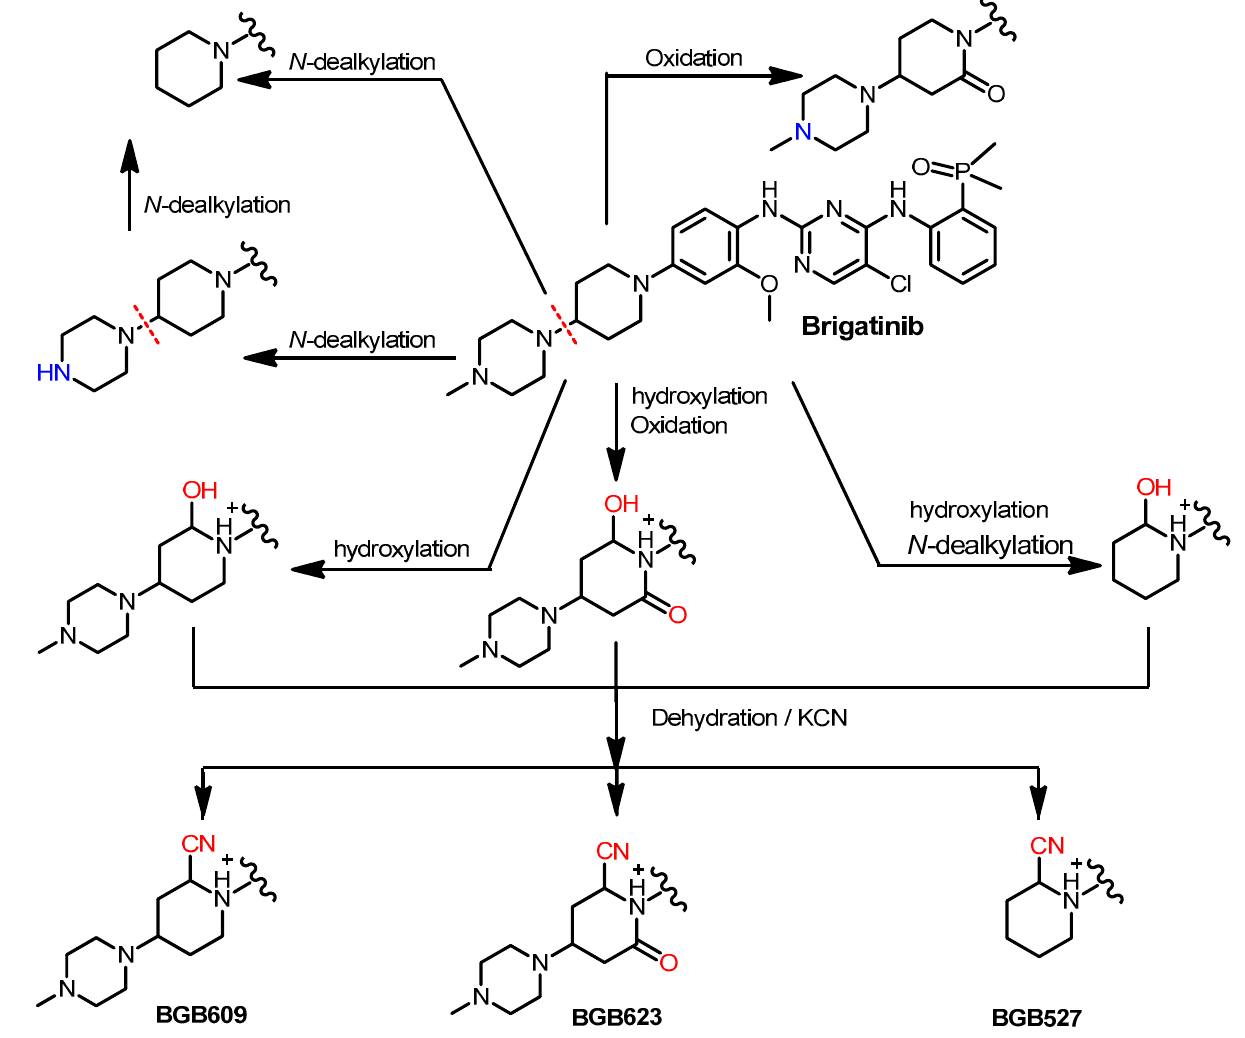
Figure 20. The proposed metabolic pathways and metabolites of brigatinib. The nitrile products, BGB609, BGB623, and BGB527, are KCN addition products that indicate the formation of the reactive iminium ion intermediates.